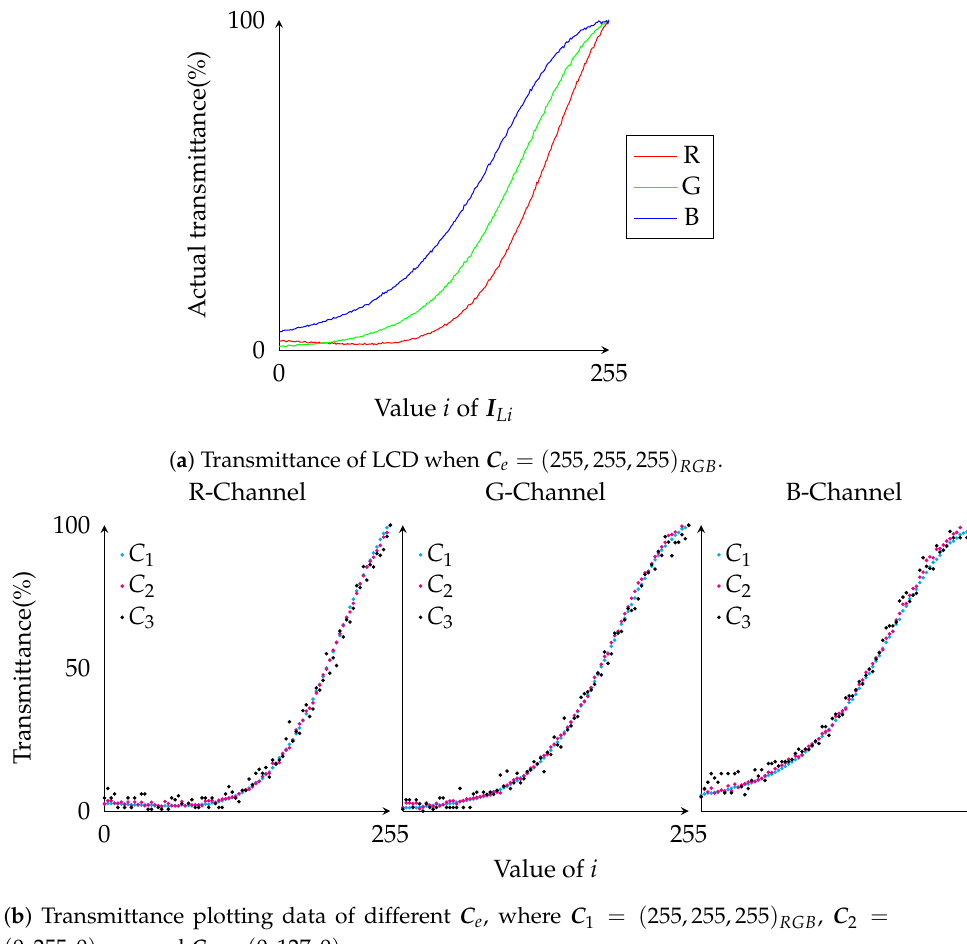
Figure 7. Transmittance curves generated by displaying I Li on the